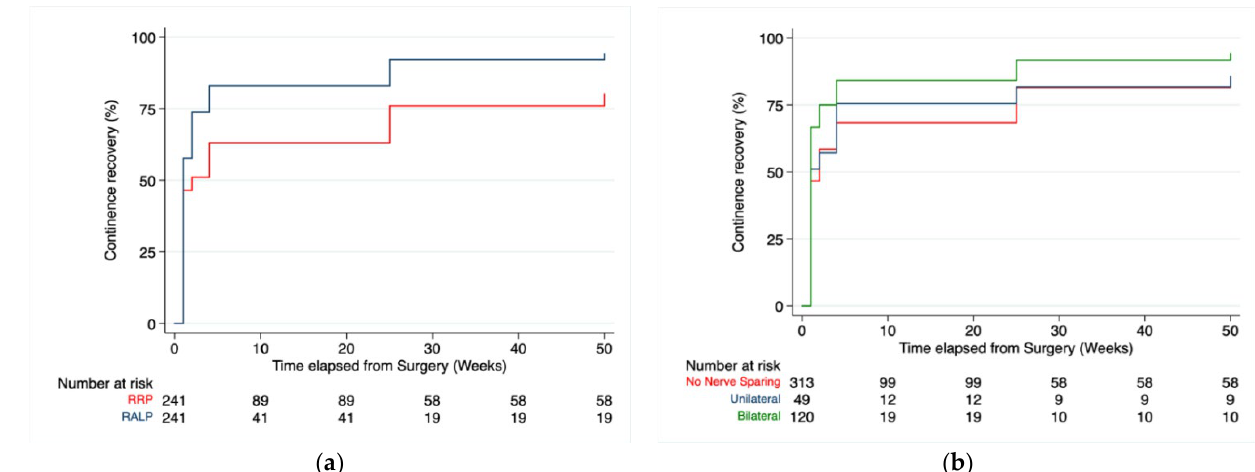
Figure 1. Continence recovery rates between RRP and RARP at follow-up after propensity matching, Pr > chi2 ≤ 0.0001 ( a ). Continence recovery rates divided by nerve sparing grade on the entire population study, Pr > chi2 = 0.0012 ( b ).